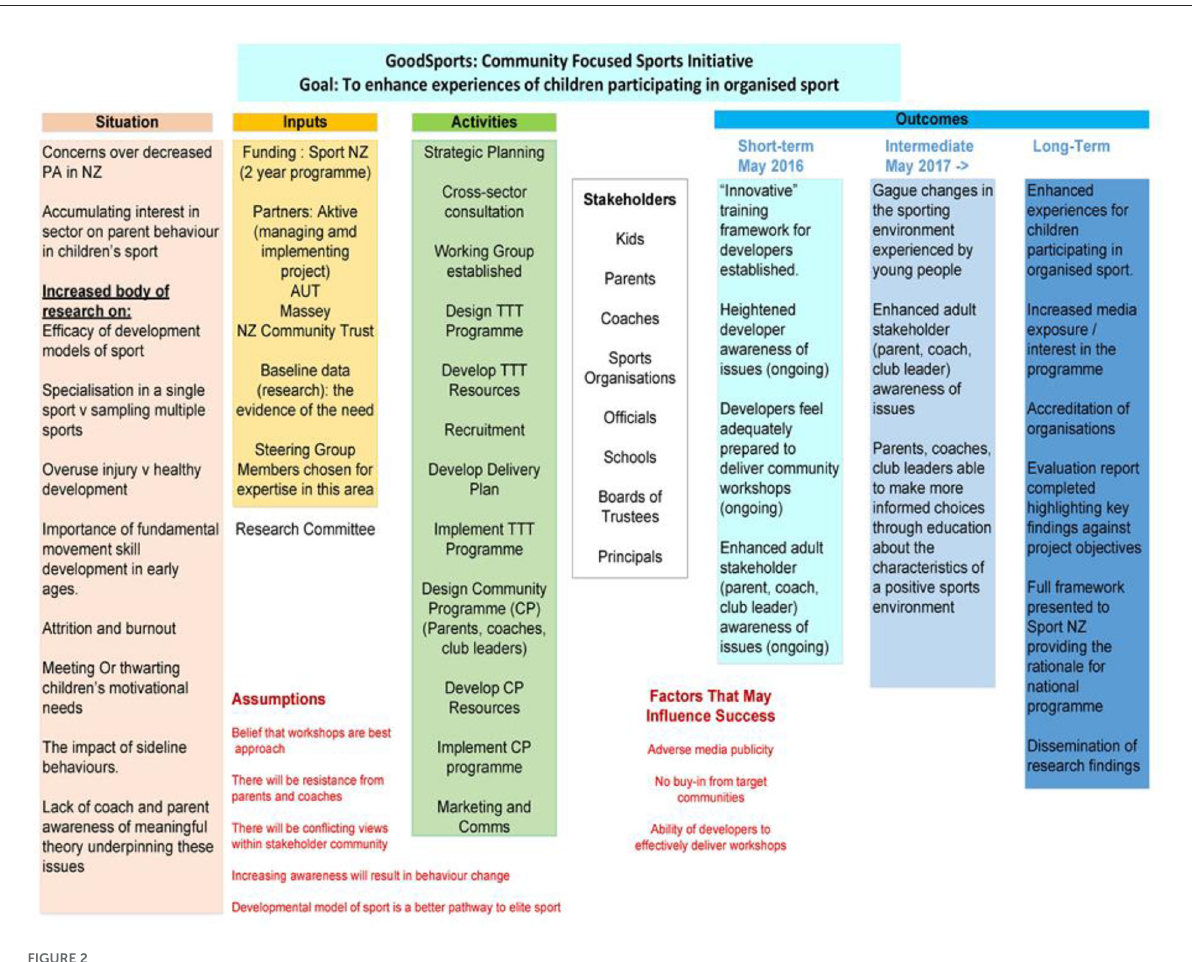
FIGURE2 Programme logic model. TTT, Train the